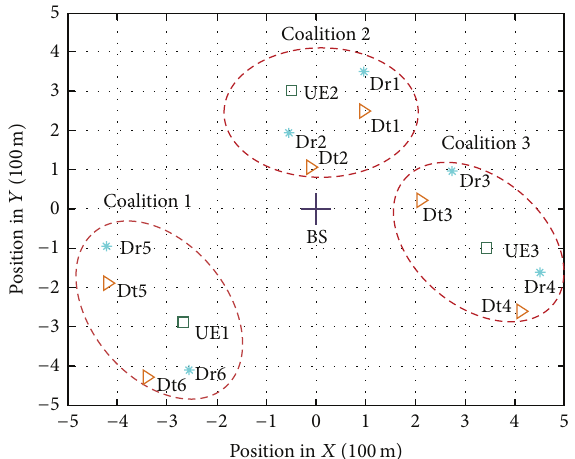
Figure 2: A final coalition structure resulting from the proposed distributed coalition formation algorithm for a network of 𝑋 = 3 UEs, 𝑌 = 6 D2D pairs, and 𝐾 = 3 links.